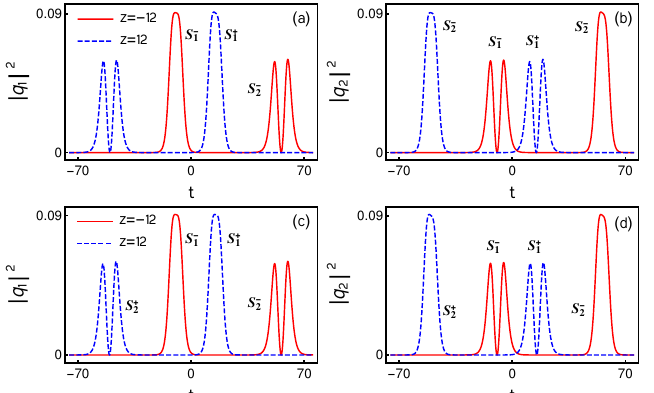
Figure 4. ( a – d ) A typical shape altering collision is displayed in the top panels. Their corresponding shape preserving nature is brought out in the bottom panels after taking a pair of position shifts, = 12.3053, z (cid:48) = z − ψ 2 = 12.27) and ( z (cid:48) = z + Ψ 1 = 12.0614, z (cid:48) = z + Ψ 2 ( z (cid:48) = z − ψ 1 2 l 1 R k 1 I 2 k 1 R k 1 I 2 l 2 R k 2 I 2 k 2 R k 2 I